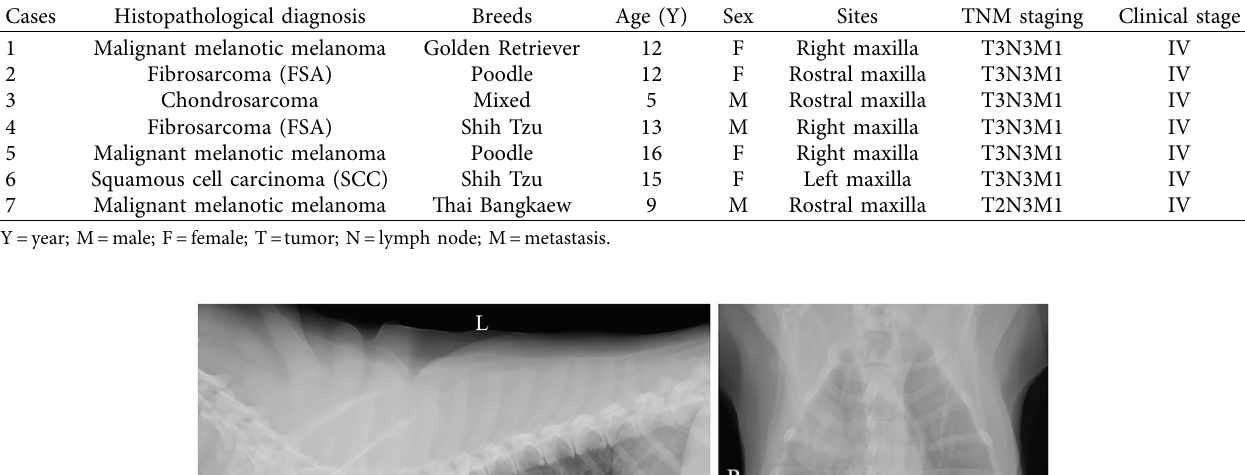
Table 4: Te histological diagnosis, signalments, the site of oral mass, TNM staging, and the clinical stage of dogs in the metastasis group. Cases